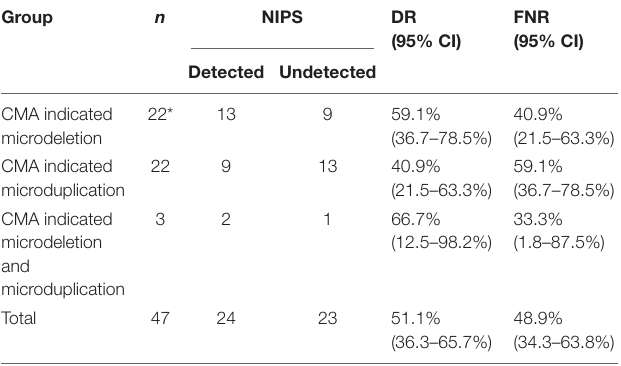
TABLE 2 | Results of NIPS in CMA prenatal